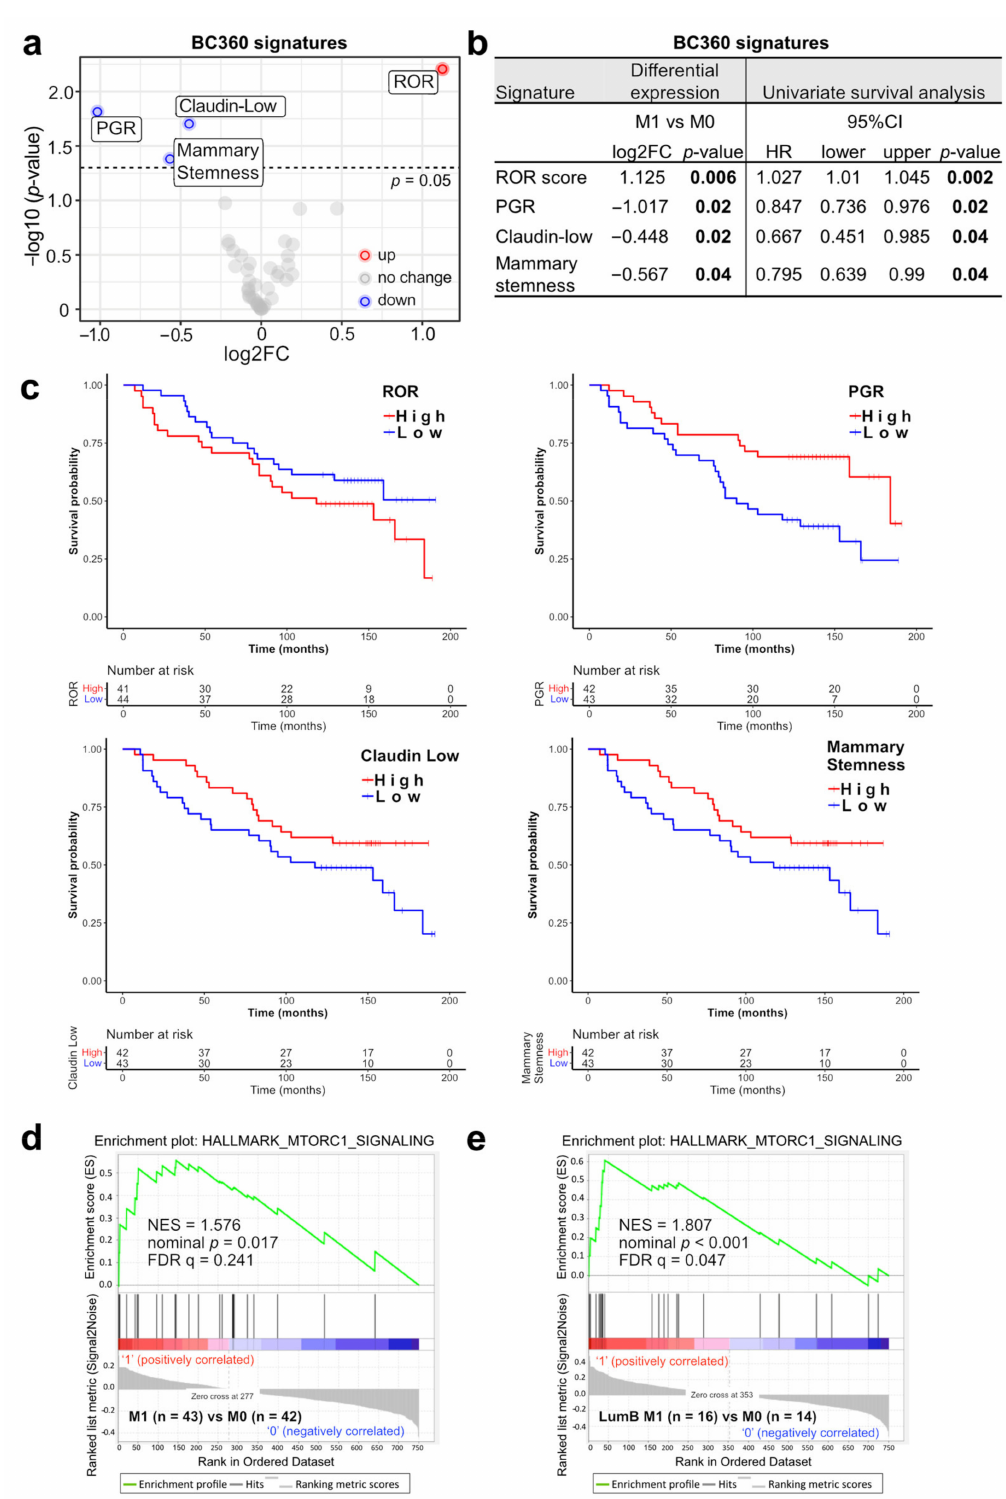
Figure 2. BC360 signatures differentially expressed in M0 vs. M1 are associated with survival. ( a ) Volcano plot of differentially expressed BC360 signatures. Log2 FC, Log2 fold change. Cutoff: p -value = 0.05. ( b ) Univariate survival analysis (calculated with Cox regression model) of significant BC360 signatures. HR, hazard ratio. CI, confidence interval. ( c ) Overall survival curves are stratified by the indicated signatures. ( d , e ) Gene set enrichment analysis (GSEA) results of M0 vs. M1 (( d ), all samples) and M0 vs. M1 in Luminal B samples only ( e ). FDR, false discovery rate, NES, normalized enrichment